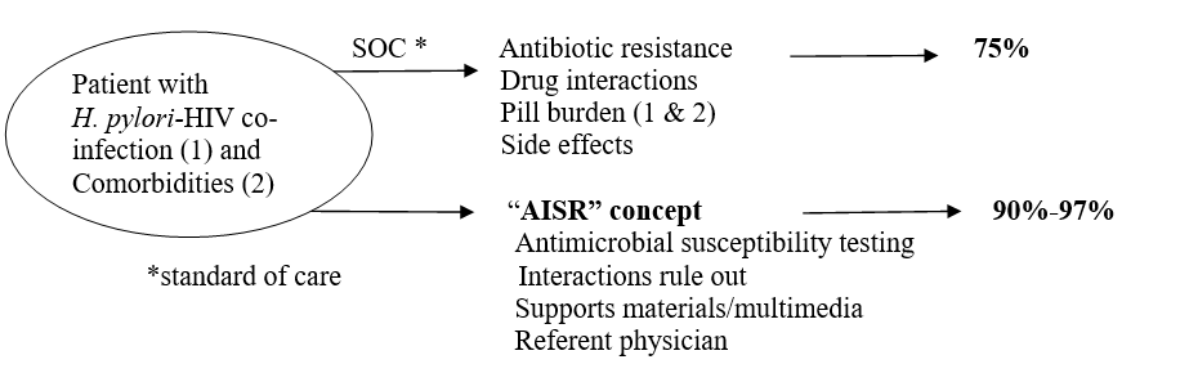
Figure 1. H. pylori treatment outcomes among H. pylori -HIV co-infected people receiving ARVs and treatment against comorbidities: H. pylori infection treatment as a function of strategies: standard of